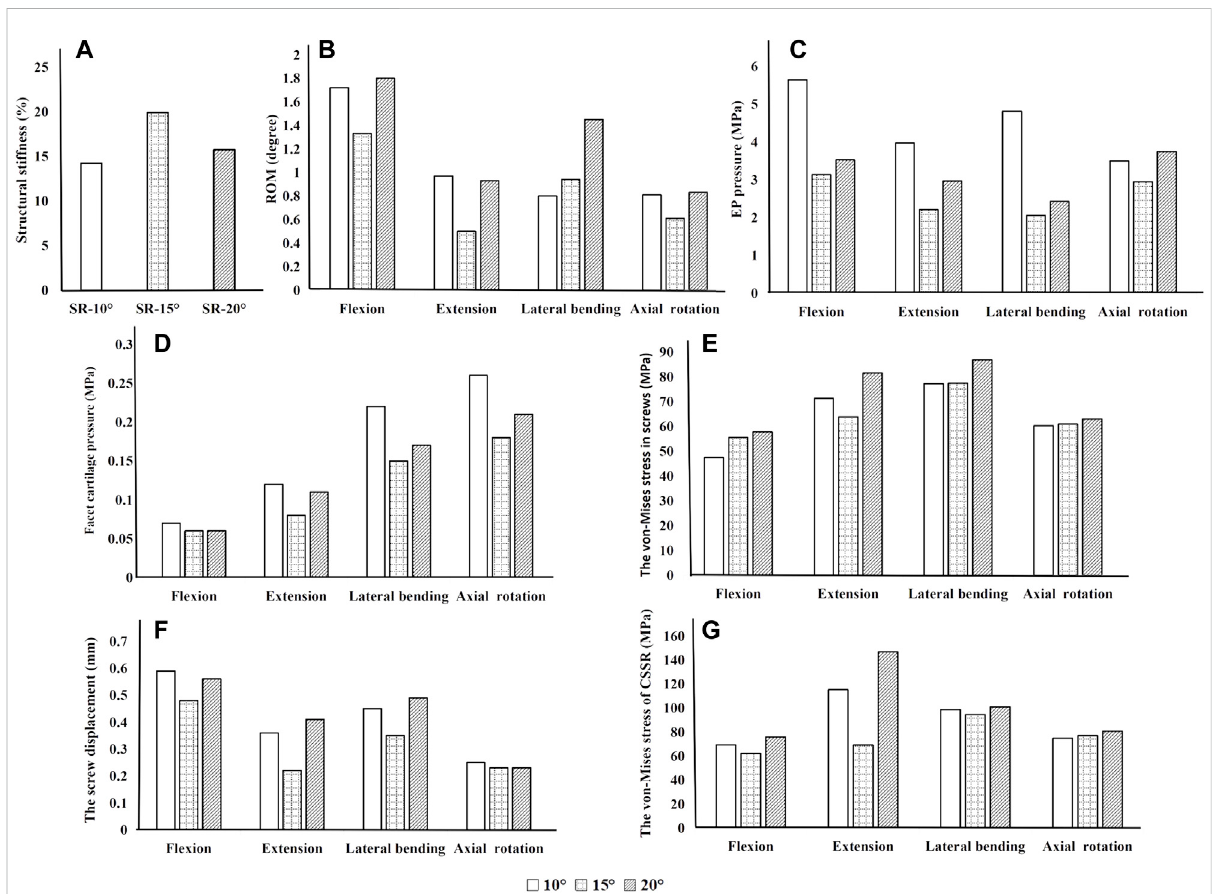
FIGURE 3 Parameters of the models for different screw inclination angles when placed under fl exion, extension, lateral bending, and axial rotation. (A) Axial stiffness, (B) segmental ROM, (C) von-Mises stress on the endplate, (D) von-Mises stress on facet cartilage, (E) von-Mises stress on screws, (F) displacement of pedicle screws, and (G) von-Mises stress of